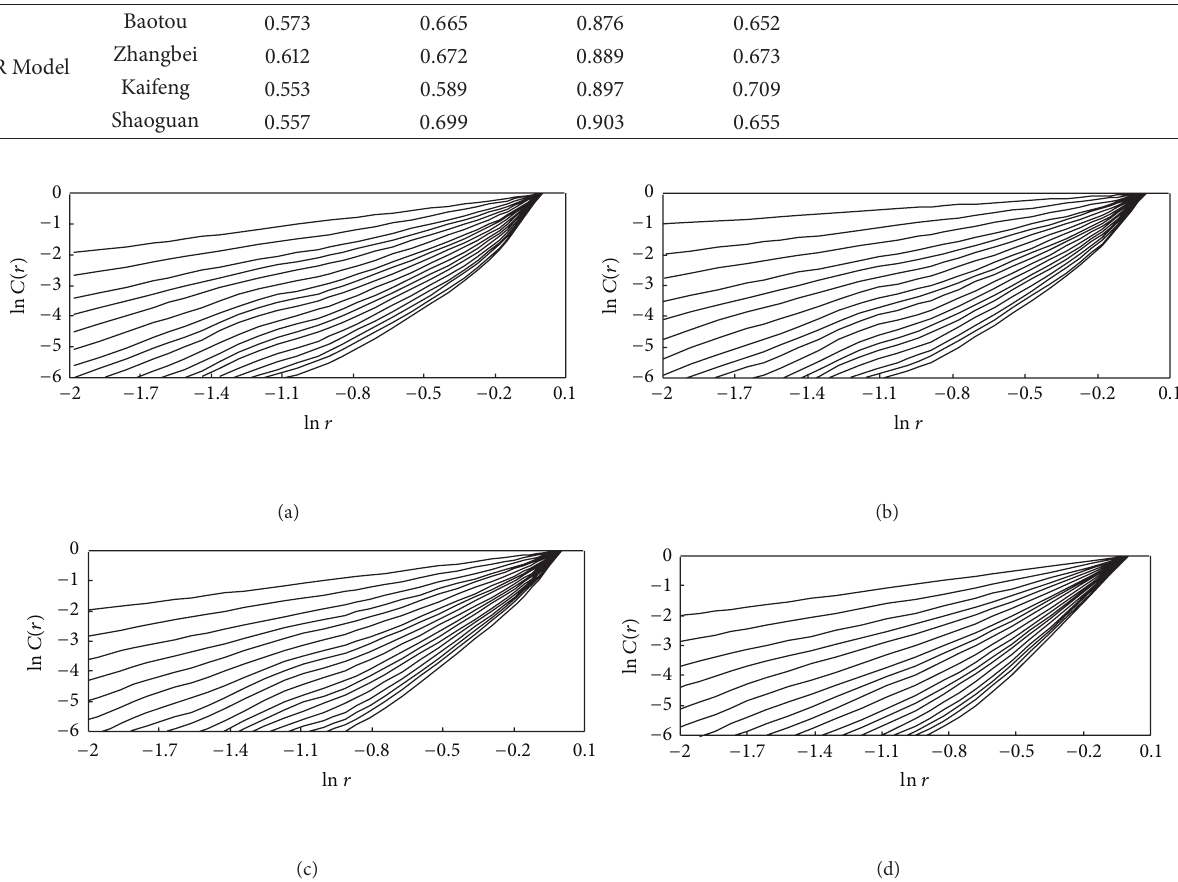
Figure 5: ln 𝐶(𝑟) versus ln 𝑟 plots for daily reference evapotranspiration series: (a) Baotou station; (b) Zhangbei station; (c) Kaifeng station; (d) Shaoguan